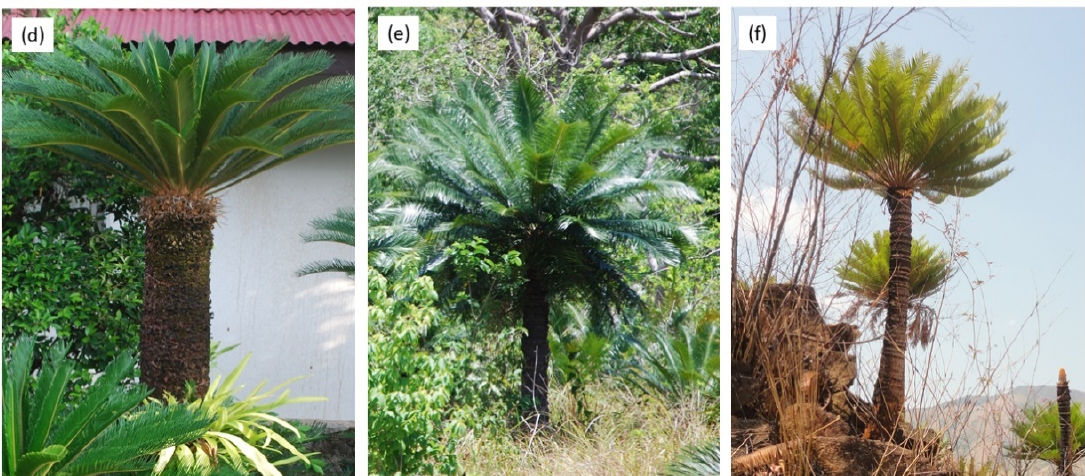
Figure 1. The general appearance of six Cycas tree species in the study locations. ( a ) Cycas edentata in an agroforest in Angeles City, Philippines; ( b ) Cycas micronesica in native Yap habitat; ( c ) Cycas nitida in its native northern Samar, Philippines habitat; ( d ) Cycas revoluta in an urban landscape in Angeles City, Philippines; ( e ) Cycas wadei in its endemic Culion Island, Philippines habitat; ( f ) Cycas zambalensis in its endemic San Antonio, Philippines habitat.